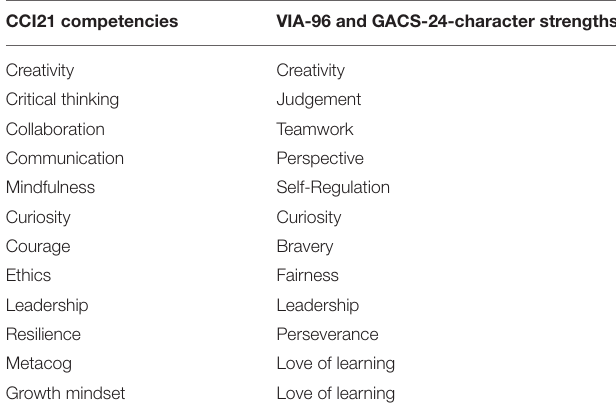
TABLE 1 | Crosswalk between competencies compound inventory for the twenty-first century (CCI21) competencies and values in action inventory of strength (VIA-96)/global assessment of character strengths